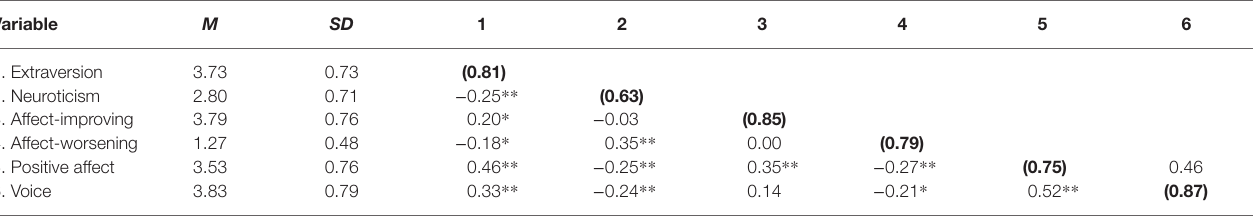
TABLE 1 | Means, standard deviations, correlations, and reliabilities. Variable